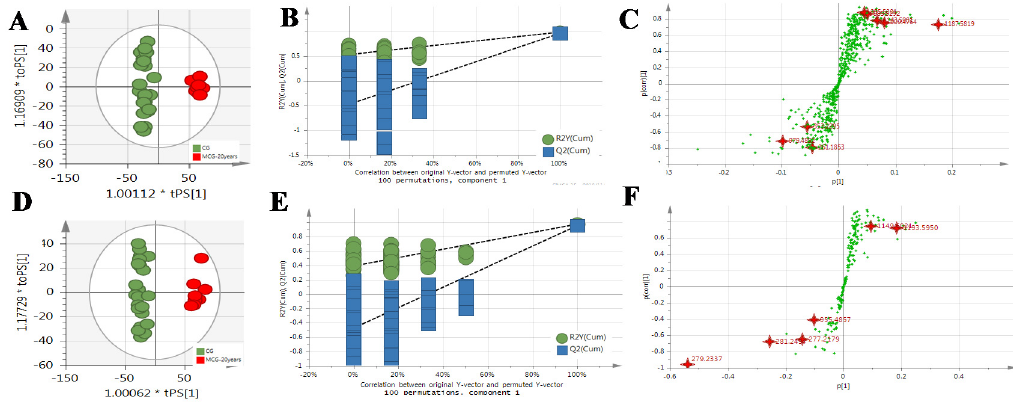
Figure 4. The OPLS-DA/Permutation test/S-Plot of CG 4–6 years and MCG 12 years in positive mode ( A / B / C ) and negative mode ( D / E / F ).